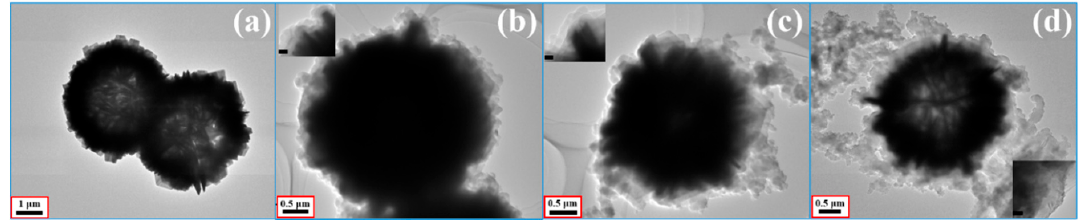
Figure 5. TEM images of ( a ) hollow CuS microspheres, ( b ) Sample A, ( c ) Sample B, and ( d ) Sample C. The insets of ( b – d ) are high-magnification TEM images of Samples A, B, and C, respectively. The inset black scale bars are 100